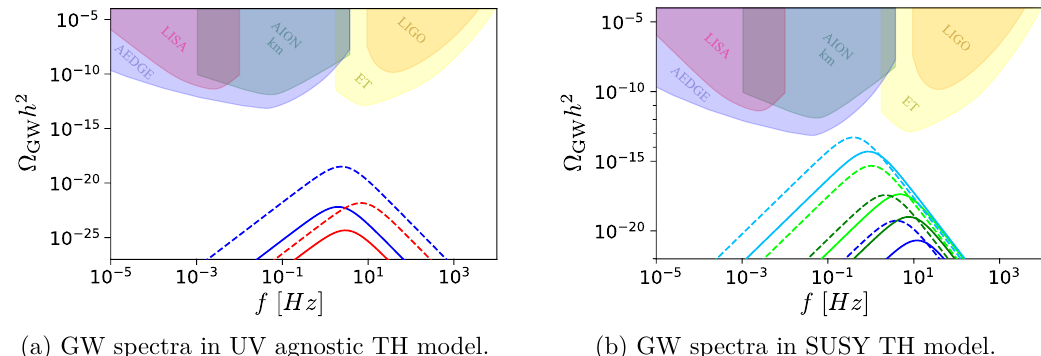
Figure 9. GW spectra for the benchmark points presented in tables 3 and 4. Shaded regions mark the integrated power-law sensitivity [85] of the existing and future GW detectors: LIGO [86], LISA [87, 88], AION [89], AEDGE [81] and Einstein Telescope [82, 83]. The LISA sensitivity was plotted based on data from the web tool PTPlot [41]. Data about the rest of detector ranges courtesy of M. Lewicki